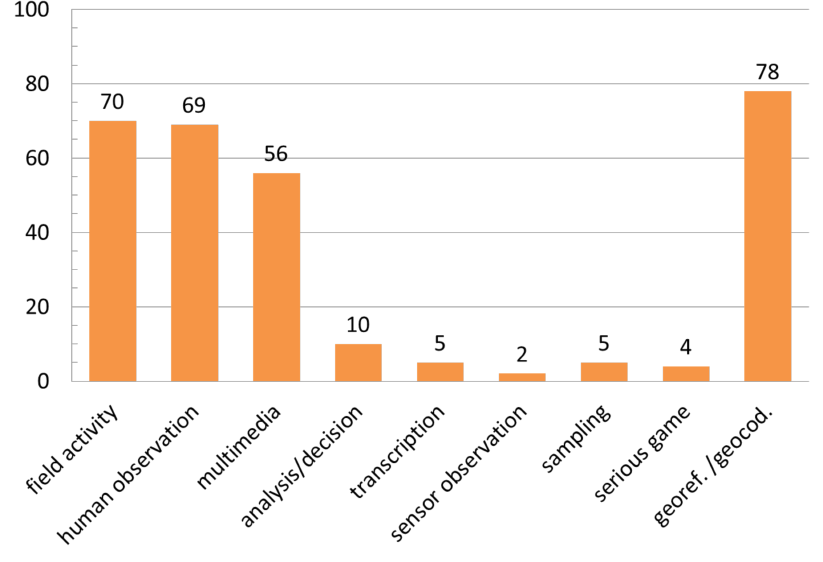
Figure 5. Summary of the results relative to the data generation